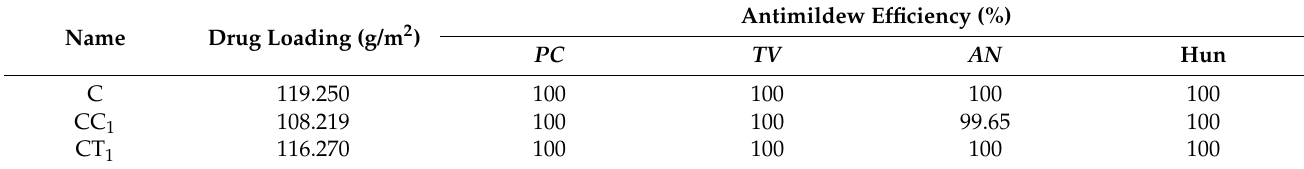
Table 4. The drug load of antimildew-treated bamboo with citral and citral compound and the control effect of antimildew treated bamboo on the 28th day (C, citral solution; CC 1 , a compound formulated with citral and cinnamaldehyde; CT 1 , a compound formulated with citral and